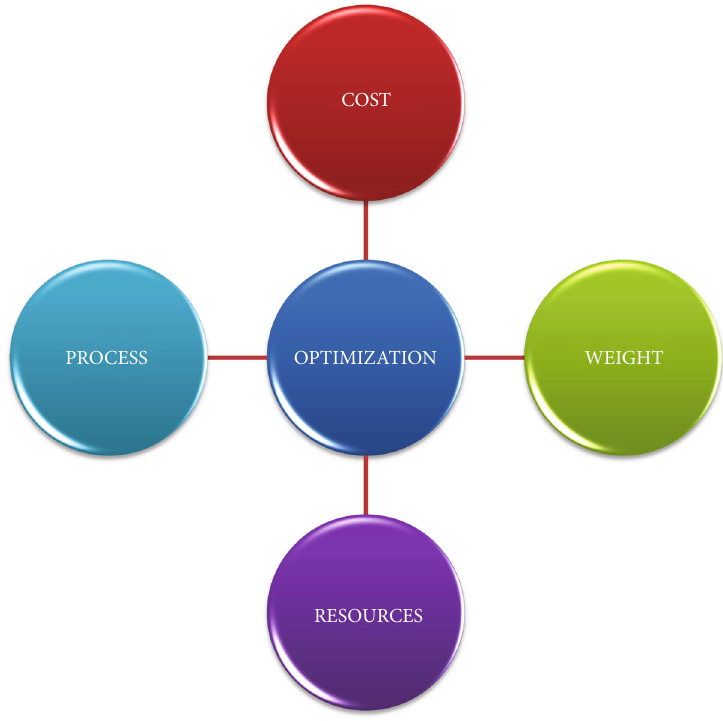
Figure 9: Di ff erent applications of